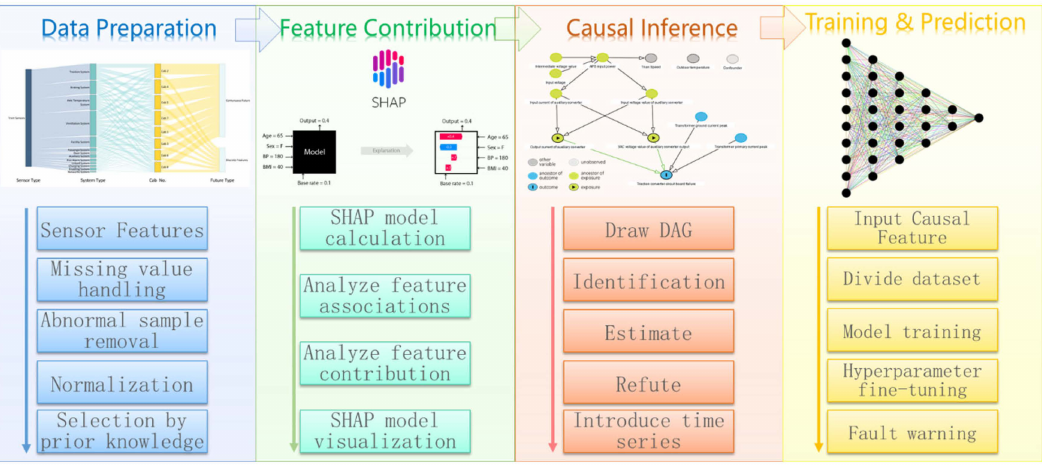
Figure 1. Overview of the research methods.